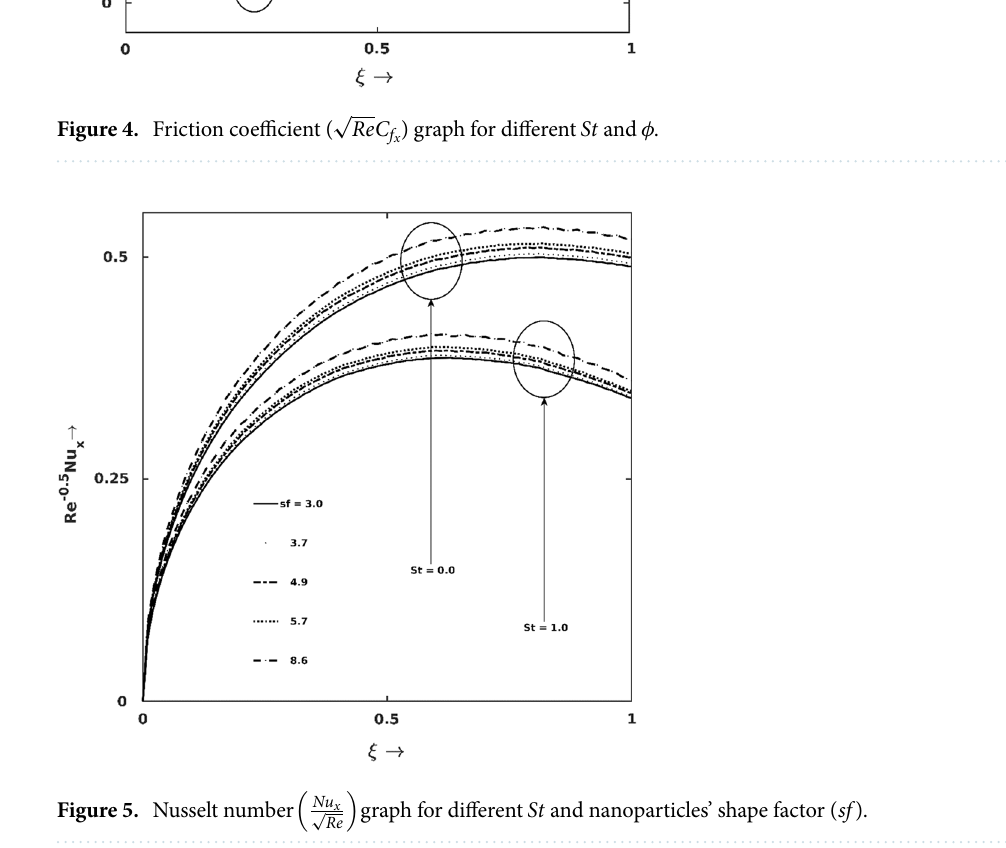
(cid:30) graph for different St and nanoparticles’ shape factor ( sf Figure 5. Nusselt number (cid:31) Nu x √ Re